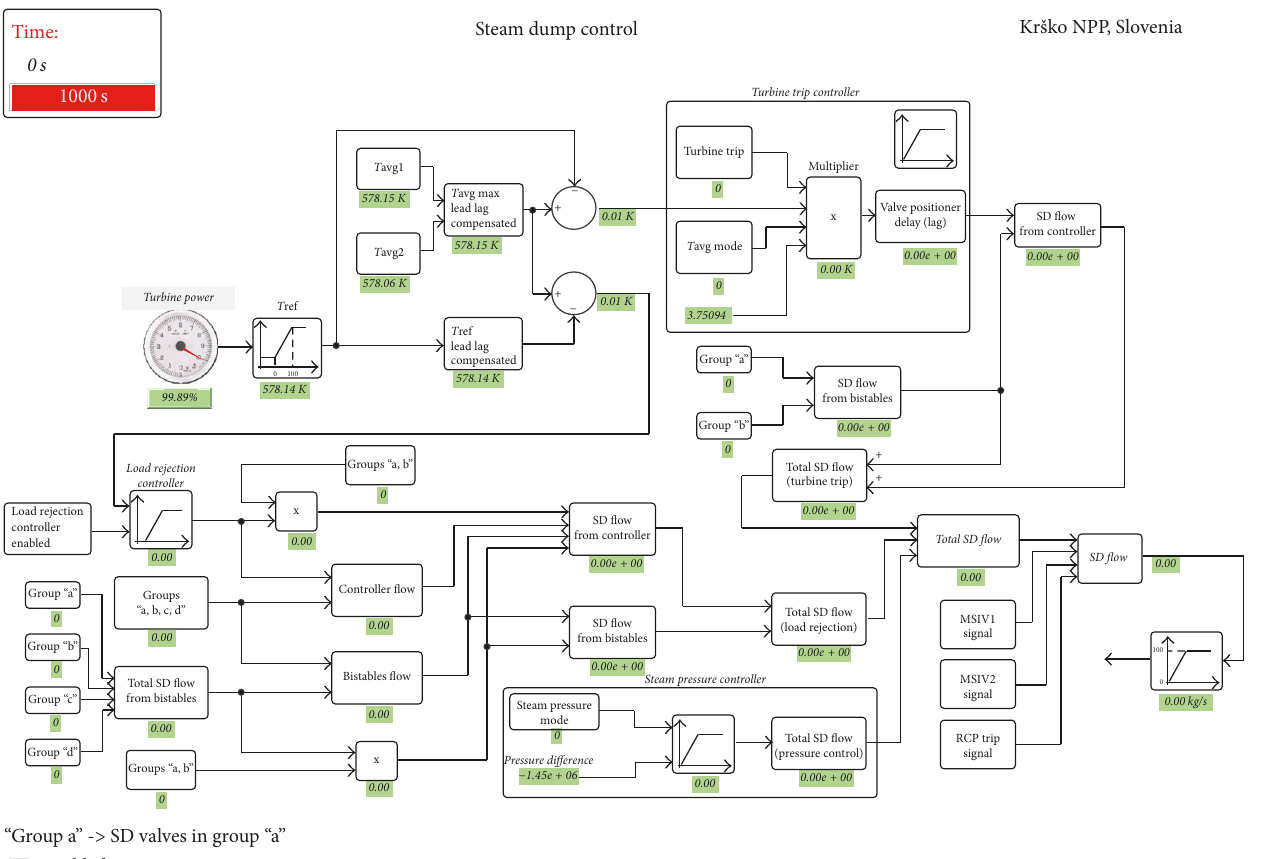
Figure 2: RELAP5 animation mask of steam dump